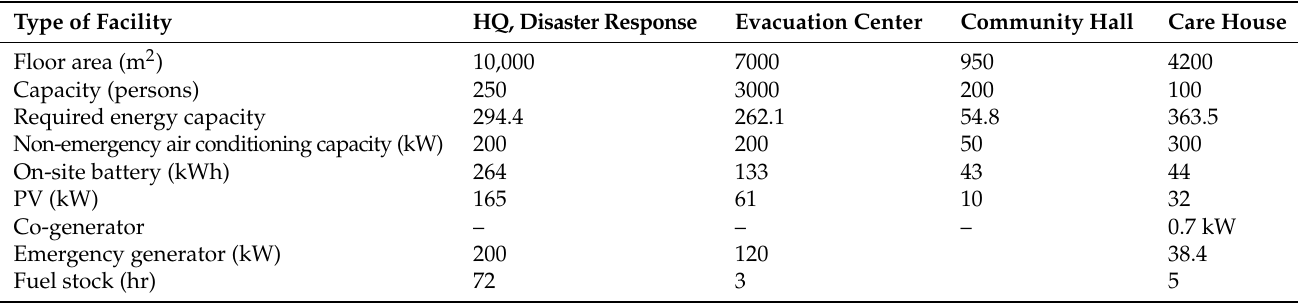
Table 1. Requirements of typical resilience facilities.